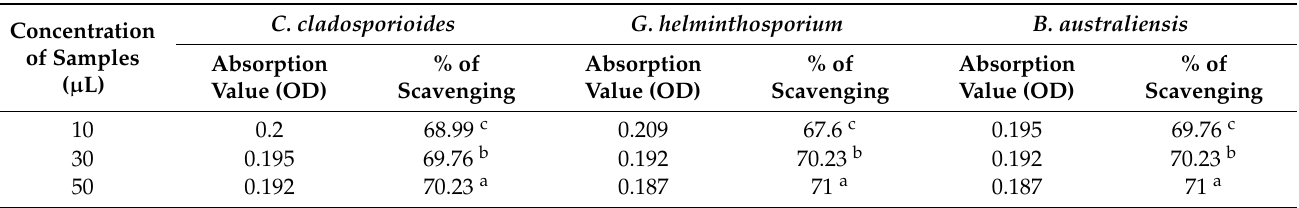
Table 4. DPPH antioxidant scavenging activity of the ethyl acetate (extracellular) extracts of Cladospo- rium cladosporioides, Graminicoloushelminthosporium , and Bipolarisaustraliensis. Data are represented as means ± SD of three replicates. Numbers within a column followed by the same alphabet letters are not significantly different according to Duncan’s multiple range test at p ≤